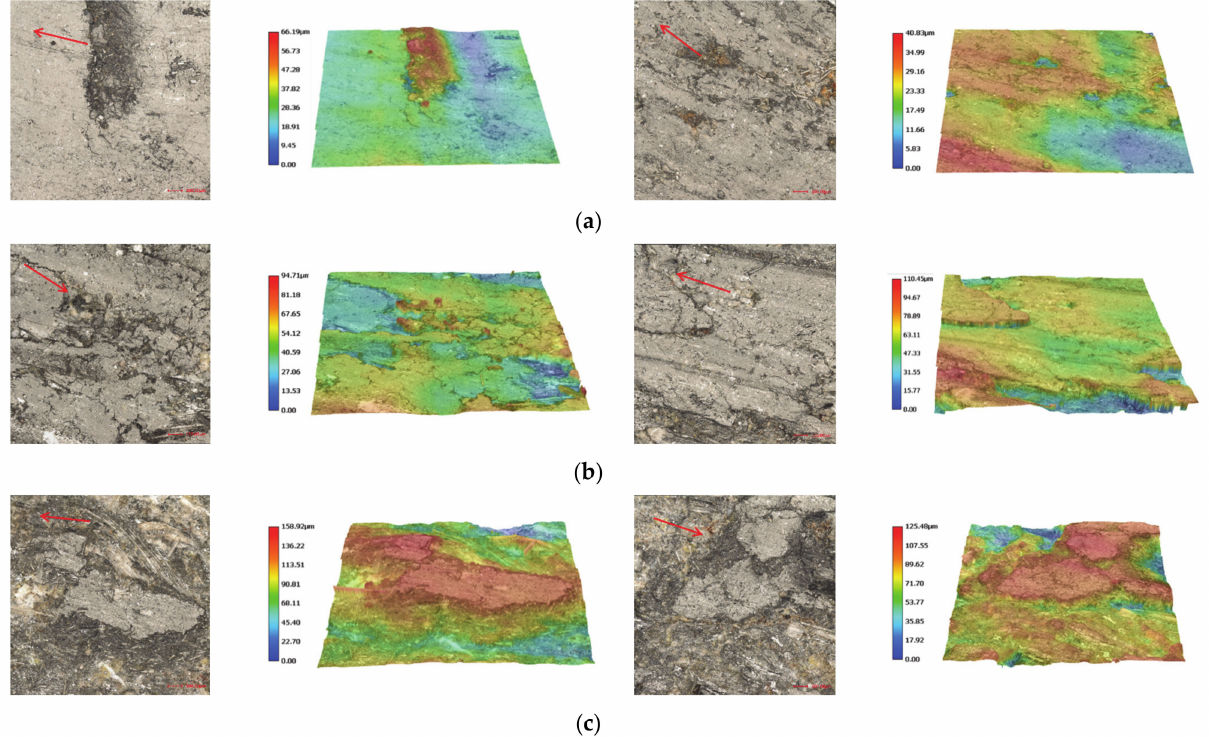
Figure 16. Microscopic morphologies and three-dimensional profiles of brake shoe specimens at both sides of the brake disc with different numbers of emergency braking cycles (the red arrow represents the sliding direction of brake disc).